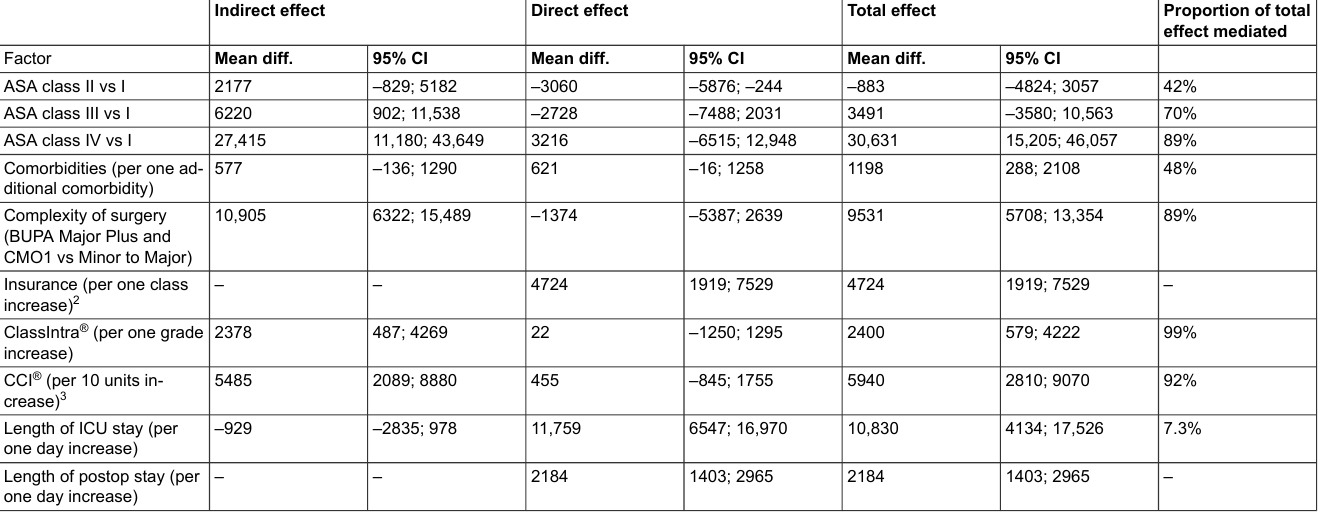
Table 3: Indirect, direct and total effects on costs (in Euros).